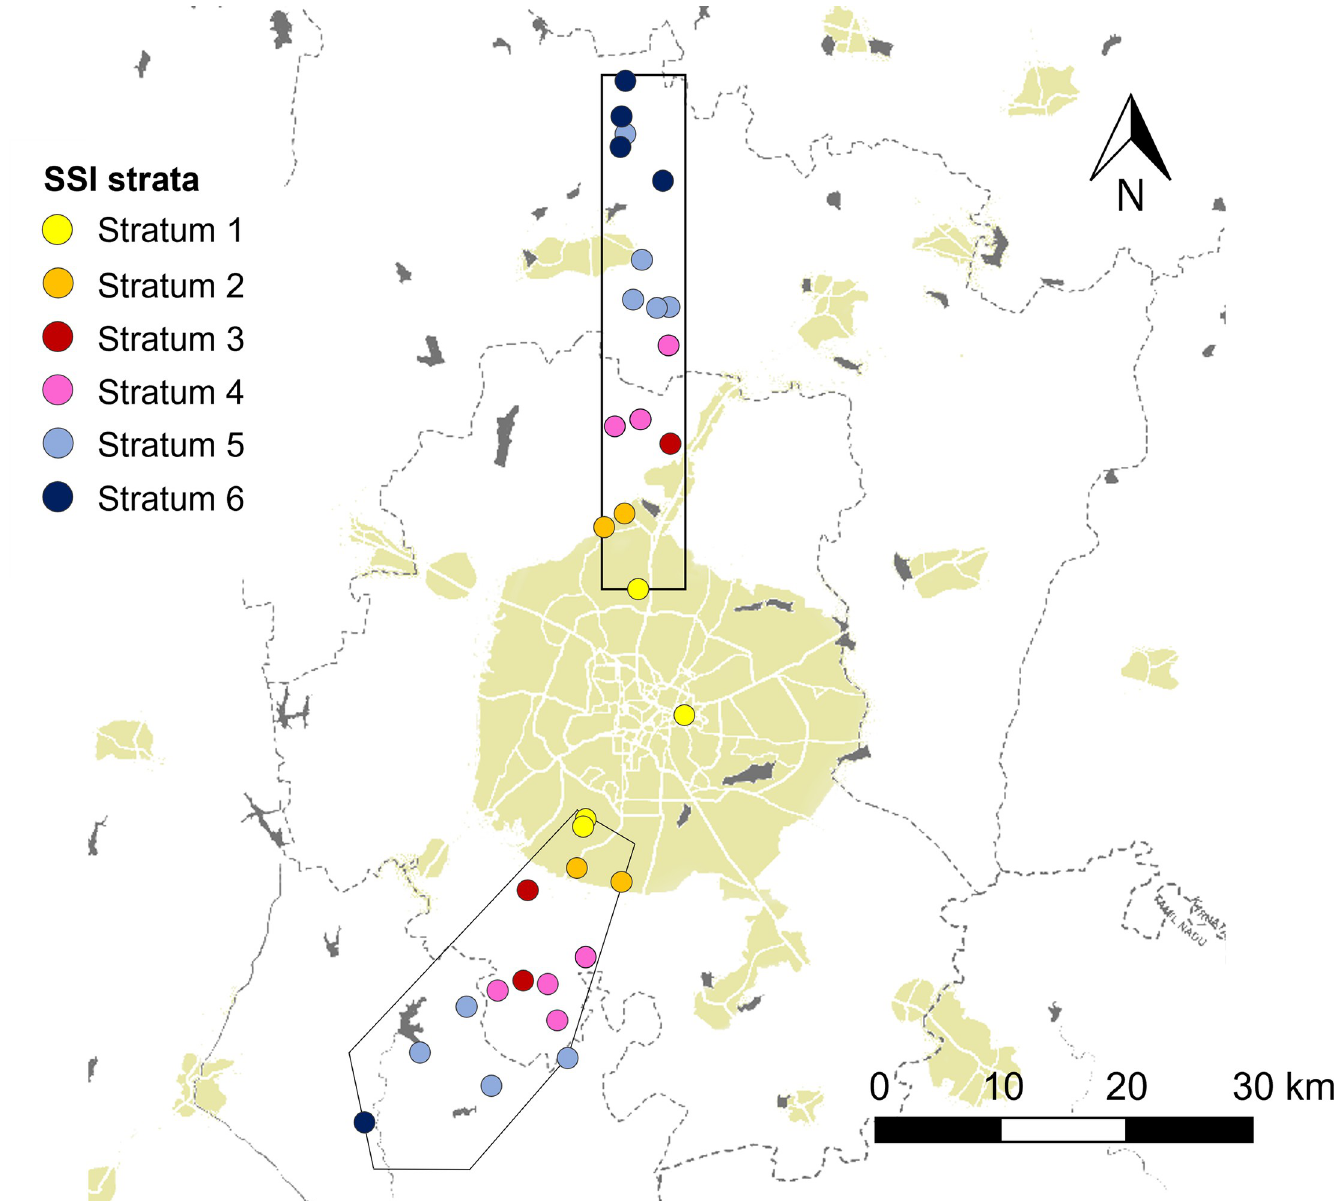
Fig 1. Map of Bengaluru (built-up area in color), northern and southern research transects and selected settlements (dots) per stratum (colors) of the Survey Stratification Index (SSI) with 1 = urban and 6 =